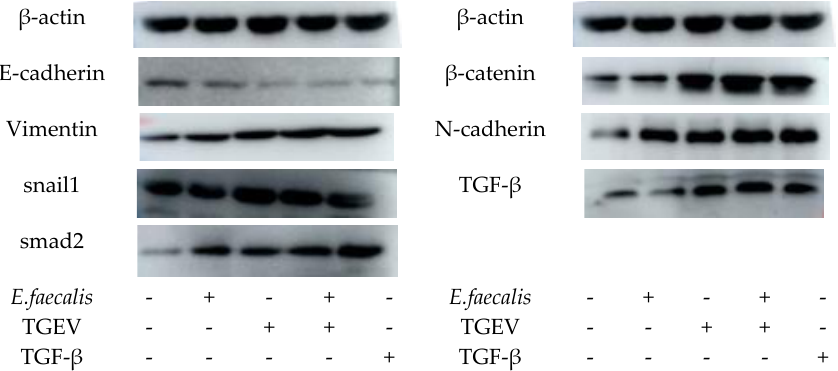
Figure A3. Western blot analysis of the effect of Enterococcus faecalis on EMT markers.